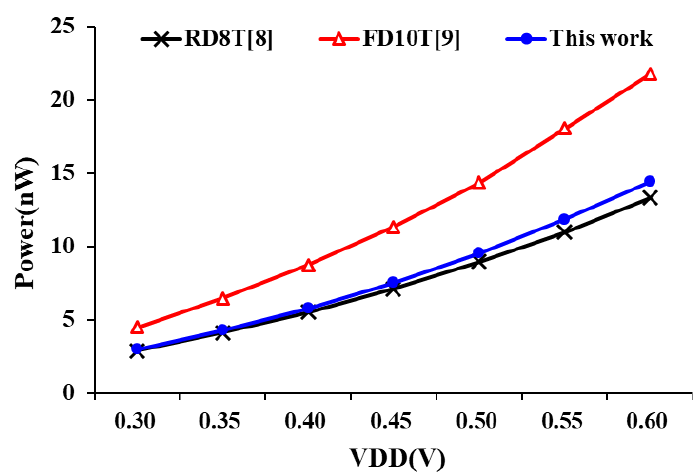
Figure 13. Power consumption of bit-cell at different supply voltages.